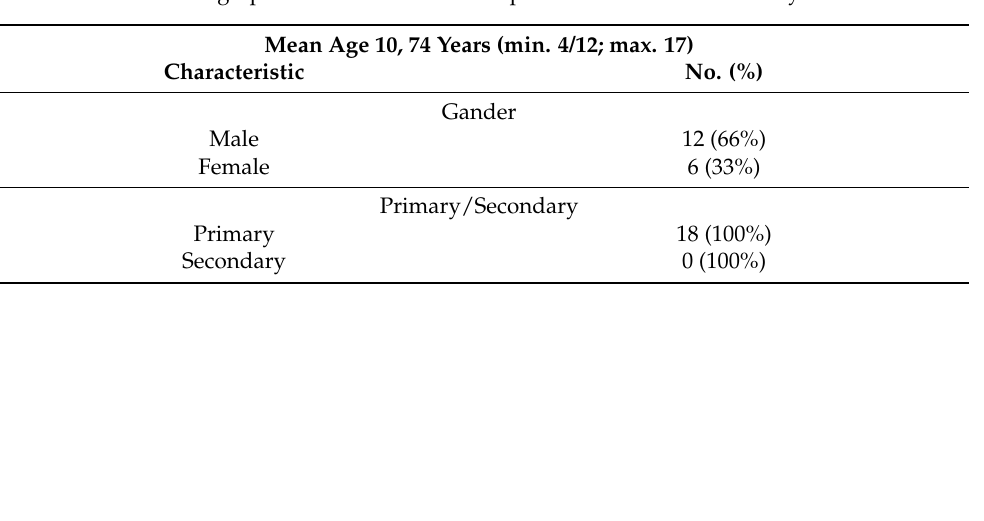
Table 1. Selected demographical and clinical data of patients enrolled to the